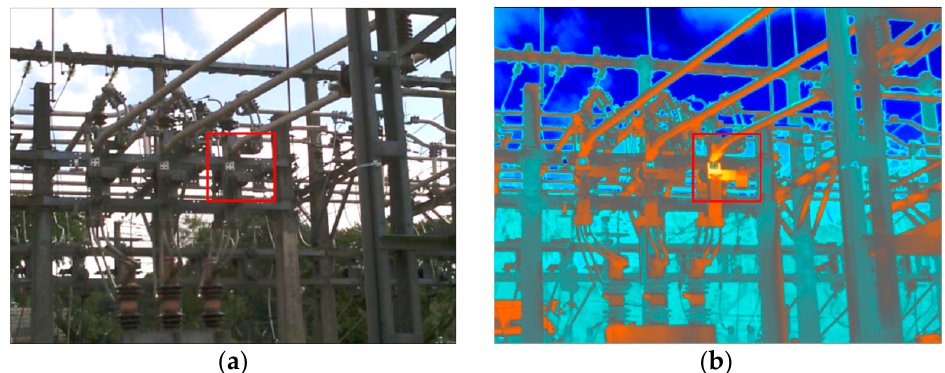
Figure 1. Images captured simultaneously by the thermal camera: ( a ) optical; ( b ) infrared. The red square represents the zoom used in the following figures to improve visualization.